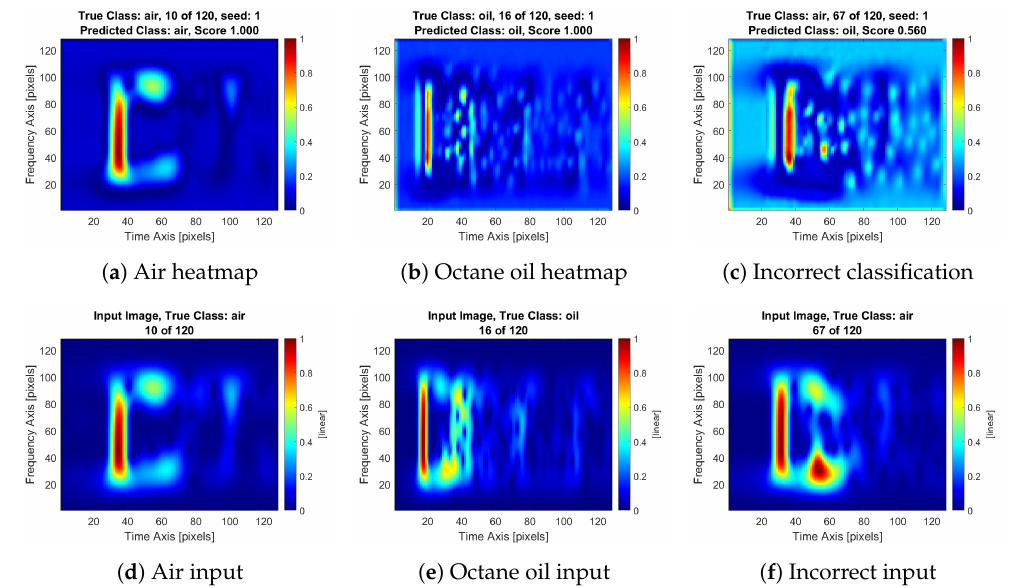
Figure 9. Grad-CAM heat maps for the CNN trained to classify the interior material. Correct classification results are shown for the ( a ) air and ( b ) octane oil interior fillings. An incorrect classification heat map ( c ) where an air-filled shell was incorrectly classified as an octane oil-filled shell is also shown. Insets ( d – f ) depict the input test image. All units are linear and have been normalized between 0 and 1.